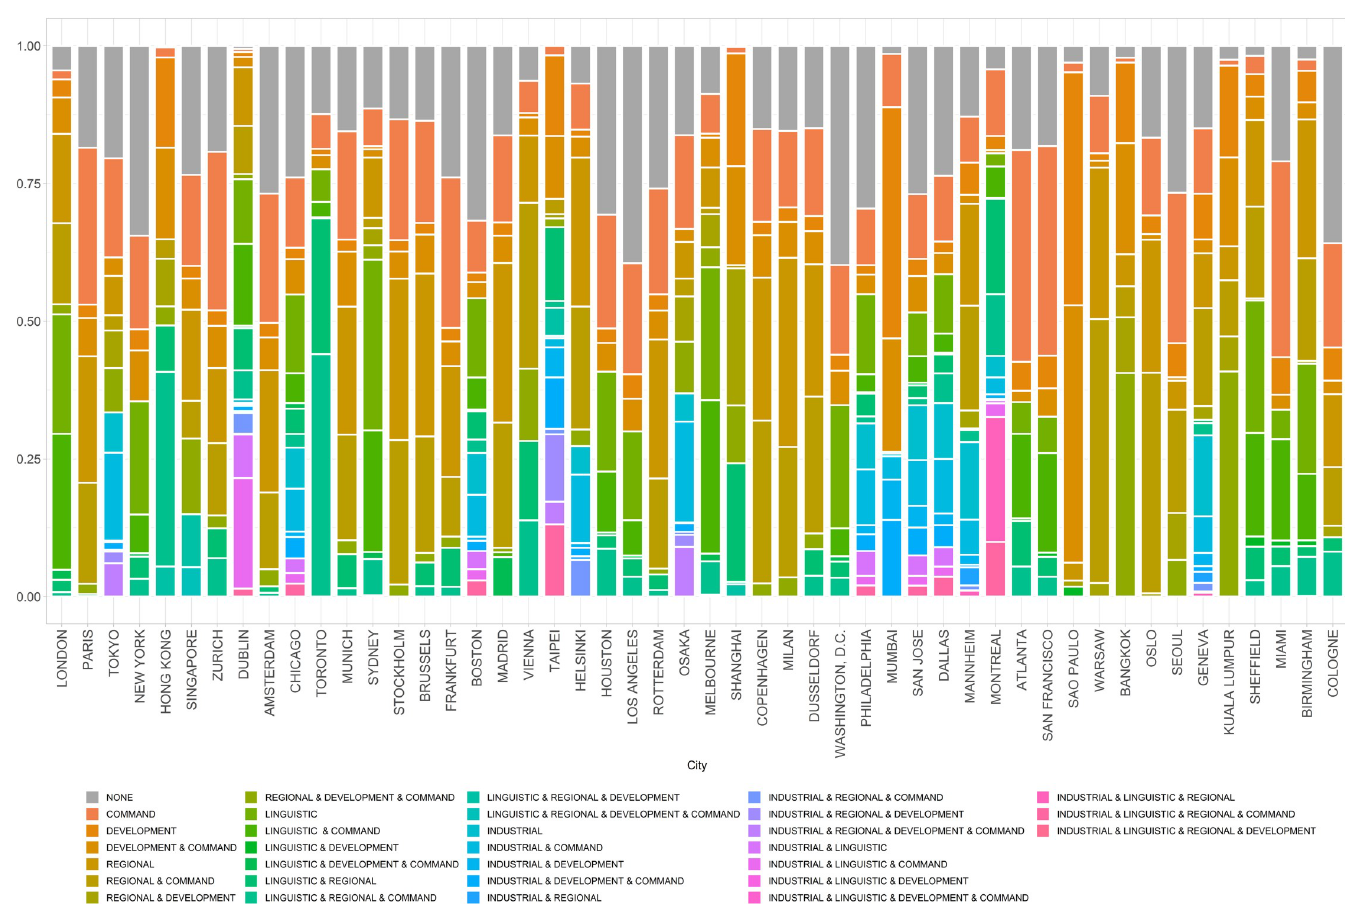
Fig 4. The 50 most connected cities in the global city network of firms by type of